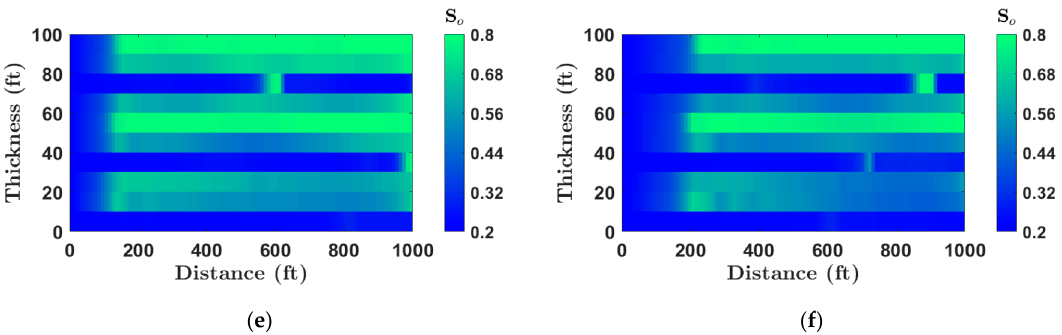
Figure 4. Oil saturation profiles for the test case using waterflooding ( a , b ), continuous polymer flooding ( c , d ), and the compositionally-tuned slug-based process ( e , f ) at t D = 1.3 ( a , c , e ) and t D = 1.7 ( b , d , f ).